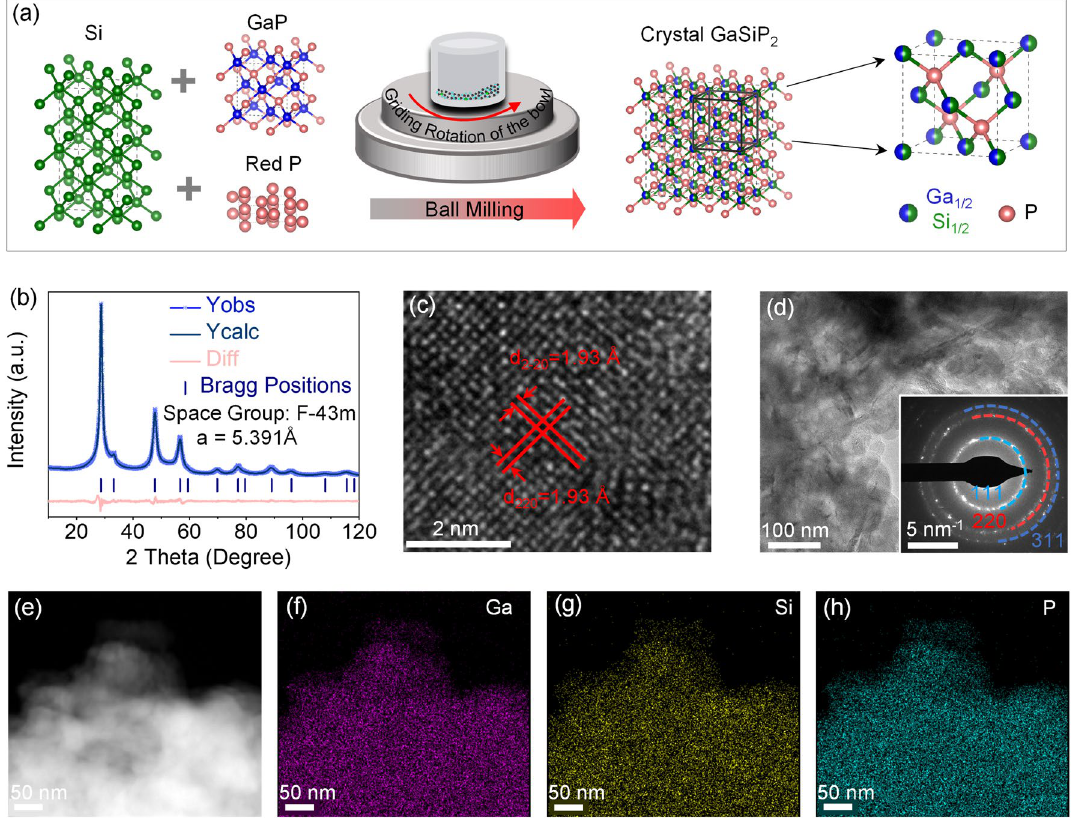
Fig. 2 a Schematic of the synthesis diagram; b XRD refinement; c – d HRTEM images with SAED pattern (inset of d ); e – h Element mapping images of the cation-mixed GaSiP 2